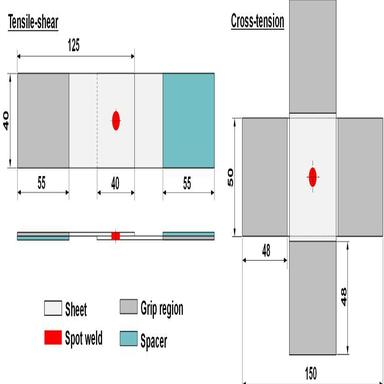
Dimensions of tensile-shear and cross-tension samples. The unit is mm.